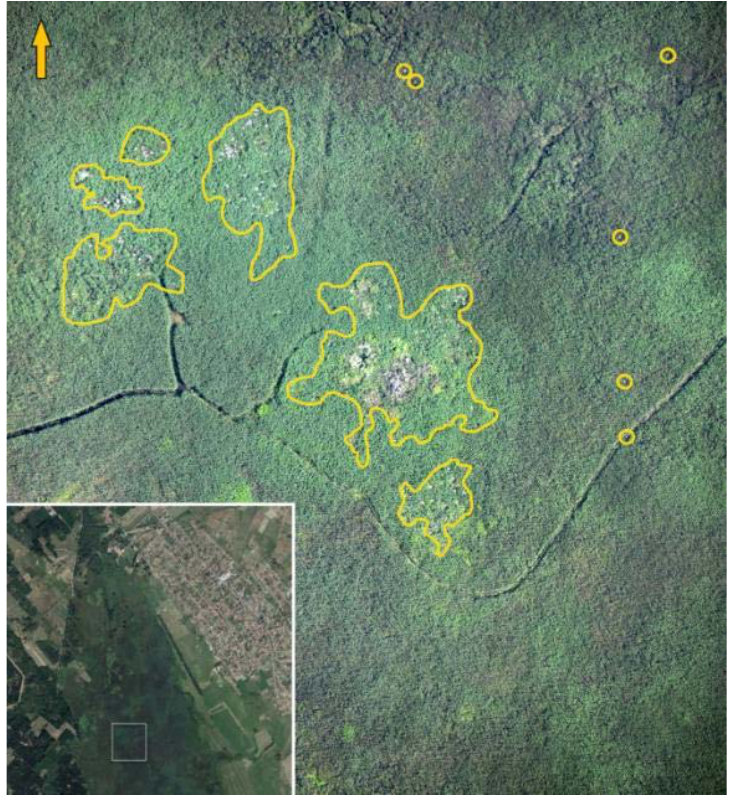
Figure 6. Breeding sites at Lake Kolon. The analysis of Lake Kolon’s heron colonies through an orthophoto mosaic with a medium resolution (7.5 cm).